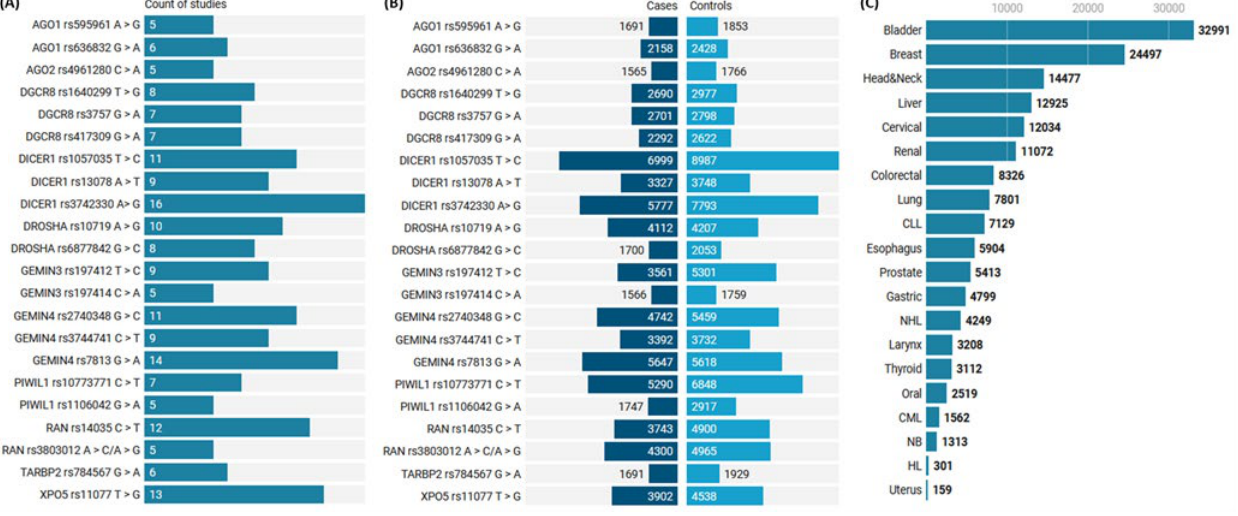
Figure 3. Characteristics of enrolled studies and SNP. ( A ) The number of studies included in the analysis of each gene variant. ( B ) The number of subjects demonstrating cases and controls. Y axis represents gene ID and SNP ID. ( C ) Count of study subjects included in the meta-analysis based on the cancer site. CLL: chronic lymphocytic leukemia, CML: chronic myeloid leukemia, HL: Hodgkin lymphoma, NB: neuroblastoma, NHL: non-Hodgkin lymphoma.